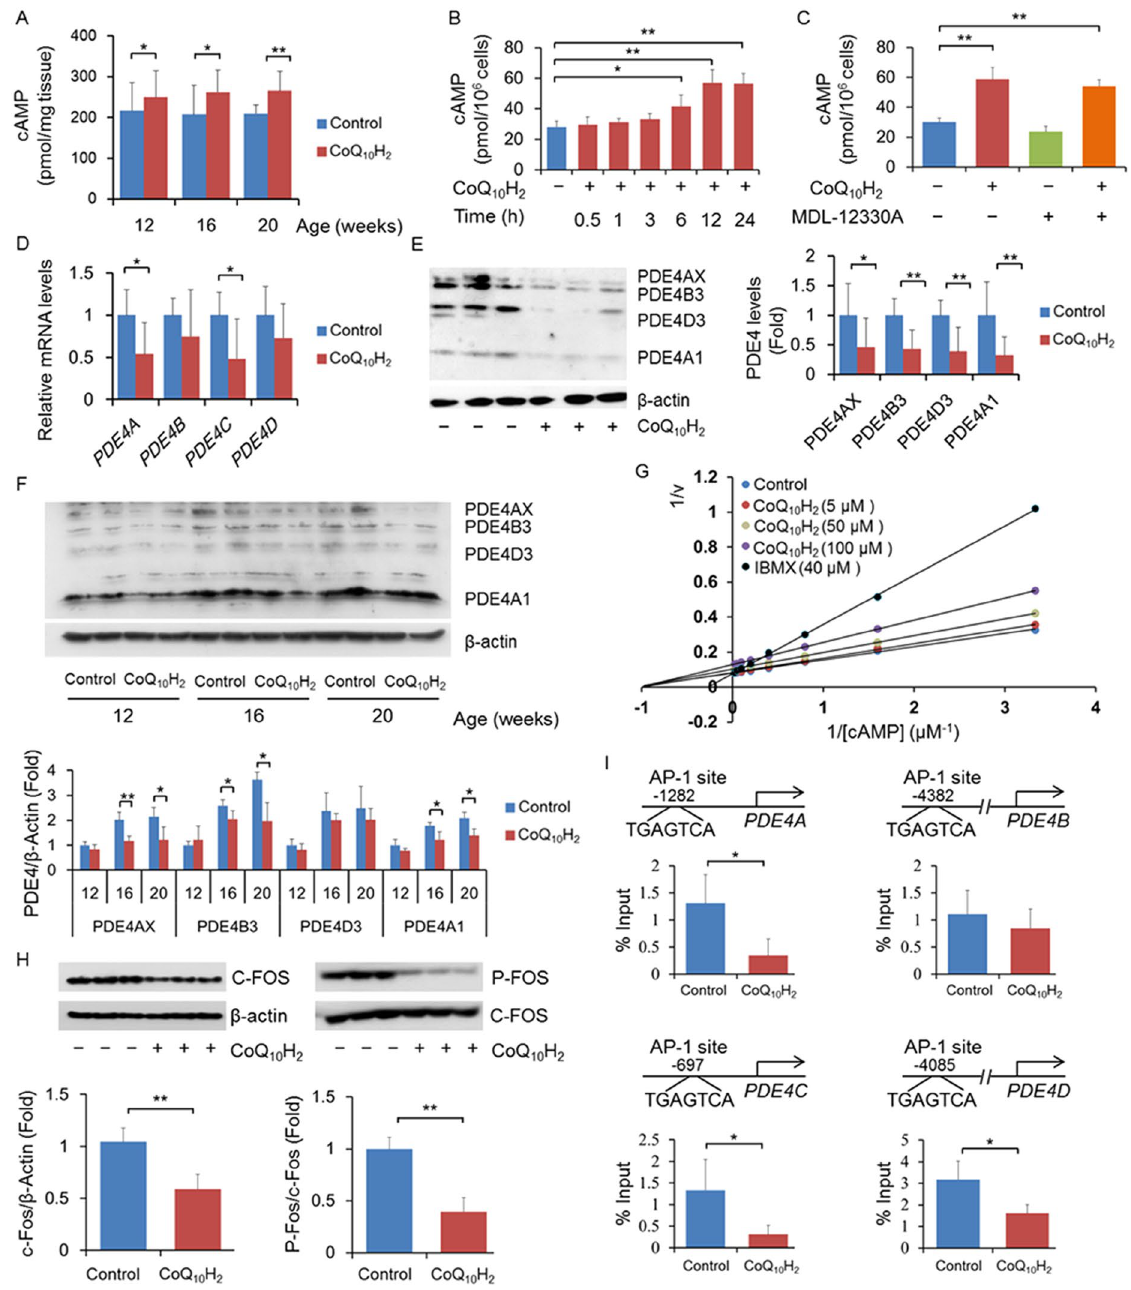
Figure 4. CoQ 10 H 2 inhibits expression of PDE4 in the liver by decreasing C-FOS binding to the PDE4 promoter. ( A ) Liver cAMP concentrations of KKAy mice in the control and CoQ 10 H 2 groups at ages 12, 16, and 20 weeks. (n = 4–6, ∗ p < 0.05, ∗∗ p < 0.01; mean ± SD, Student’s t-test); ( B ) Change in intracellular cAMP concentration in HepG2 cells 0.5–24 hours after the addition of CoQ 10 H 2 (5 μ M). (n = 6, ∗∗ p < 0.01; mean ± SD, one-way ANOVA followed by Tukey’s test); ( C )MDL-12330A (50 μ M) pre-treated or untreated HepG2 cells were supplemented with CoQ 10 H 2 (5 μ M) for 24 hours and then intracellular cAMP was measured. (n = 6, ∗∗ p < 0.01; mean ± SD, one-way ANOVA followed by Tukey’s test); ( D ) mRNA expression levels of PDE4 in HepG2 cells 24 hours after addition of CoQ 10 H 2 (5 μ M) were determined by real-time PCR. Histograms show fold-change of the mRNA level relative to untreated control cells. (n = 9, ∗ p < 0.05, ∗∗ p < 0.01; mean ± SD, Student’s t-test); ( E , F ) PDE4 protein content in HepG2 cells ( E ) and KKAy mouse liver (F ) was measured by western blotting. Densitometric quantification is depicted in the right panel (n = 4–6, ∗ p < 0.05, ∗∗ p < 0.01; mean ± SD, Student’s t-test); ( G ) Lineweaver-Burk plots show kinetic analysis of PDE activity at 0.3 to 40 μ M cAMP. ( H ) Levels of C-FOS protein and its phosphorylation in HepG2 cells 24 hours after CoQ 10 H 2 (5 μ M) supplementation were measured by western blotting. All blots were obtained under the same experimental conditions, and cropped images of the blots are shown (n = 9, ∗∗ p < 0.01; mean ± SD, Student’s t-test); ( I ) The binding capacity of C-FOS and the PDE4 promoter as detected by ChIP (n = 9, ∗ p < 0.05; mean ± SD, Student’s